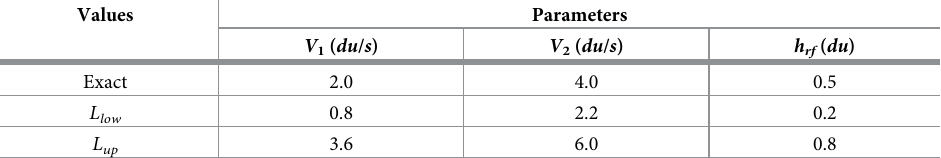
Table 6. True model parameter and constraints. The exact values of the parameters V 1 , V 2 and h rf for true model and their lower ( L low ) and upper ( L up )